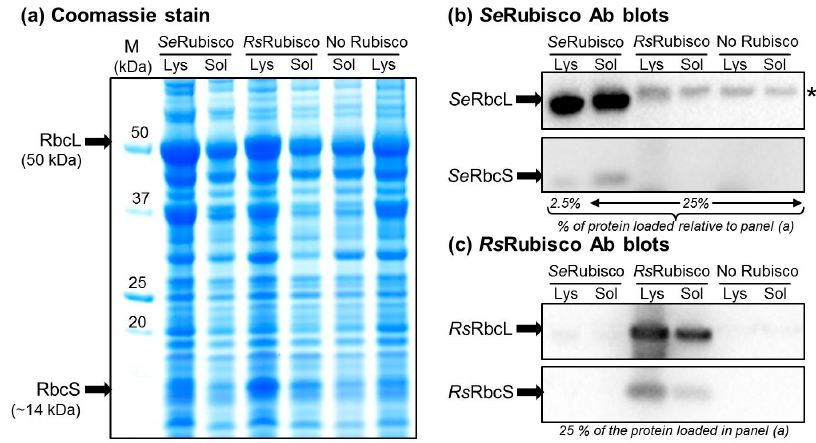
Figure 2. SDS PAGE analysis of Se Rubisco and Rs Rubisco production in BL21(DE3). Rubisco production was induced at 25 °C with 0.5 mM isopropyl- β - D -thiogalactosidase (IPTG) for 8 h, the cells were lysed and ( a ) 4 μ g of soluble protein (Sol) and an equivalent volume of the total cellular protein (Lys, comprising soluble, membrane and insoluble inclusion body proteins) were separated by SDS PAGE and Coomassie stained. Duplicate PAGE gels loaded with lower amounts of each protein preparation (as indicated) were blotted onto nitrocellulose membranes and probed with antibodies (Ab) to ( b ) Se Rubisco and ( c ) Rs Rubisco. Empty vector BL21(DE3)-pET28a(+) cells were used as a “no Rubisco” control. *, E. coli protein recognized by the Se Rubisco antibody. The Se RbcL is produced in high abundance and mostly insoluble (lysate signal >> soluble signal), while Se RbcS, Rs RbcL and Rs RbcS are mostly soluble. Se Rubisco and Rs Rubisco L 8 S 8 contents comprised, respectively, 1.1% and 4.8% ( w / w ) of the soluble cellular protein (as quantified by 14 C- carboxyarabinitol 1,5-bisphospahte (CABP)-binding). M, protein markers (sizes